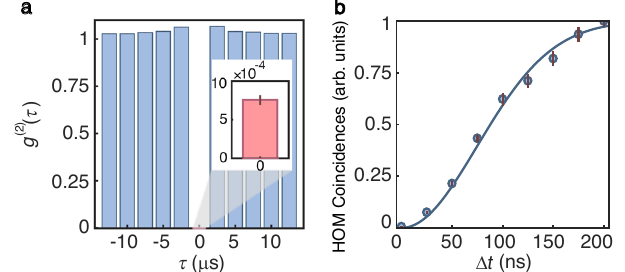
Fig. 2 | High-quality Rydberg single-photon source. a Second-order intensity correlation function g (2) ( τ ) as a function of delay τ . The duration of each experi- mental cycle is 2.5 μ s. The insert shows g (2) (0) at zero delay. A 200-ns detection window is applied. b The normalized coincidences in HOM experiment as a func- tion of two-photon temporal mismatch Δ t . The solid curve is a Gaussian fi t. The errorbarsrepresentthe1 σ standarddeviationfromphotoelectriccountingevents.